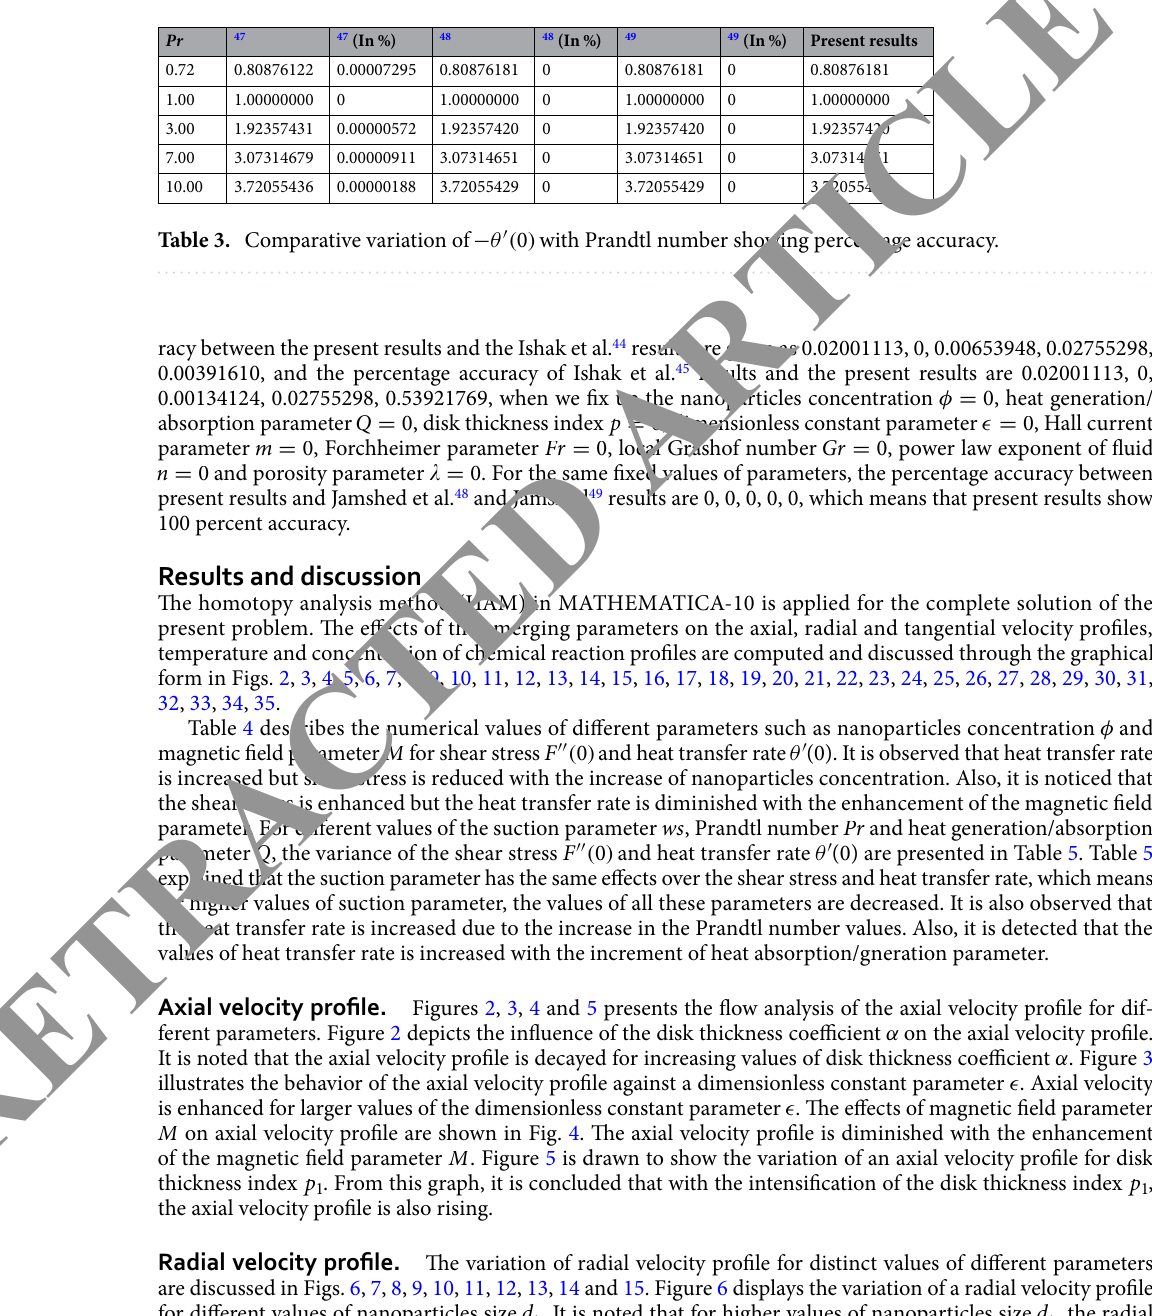
θ ′ ( 0 ) with Prandtl number showing percentage accuracy.